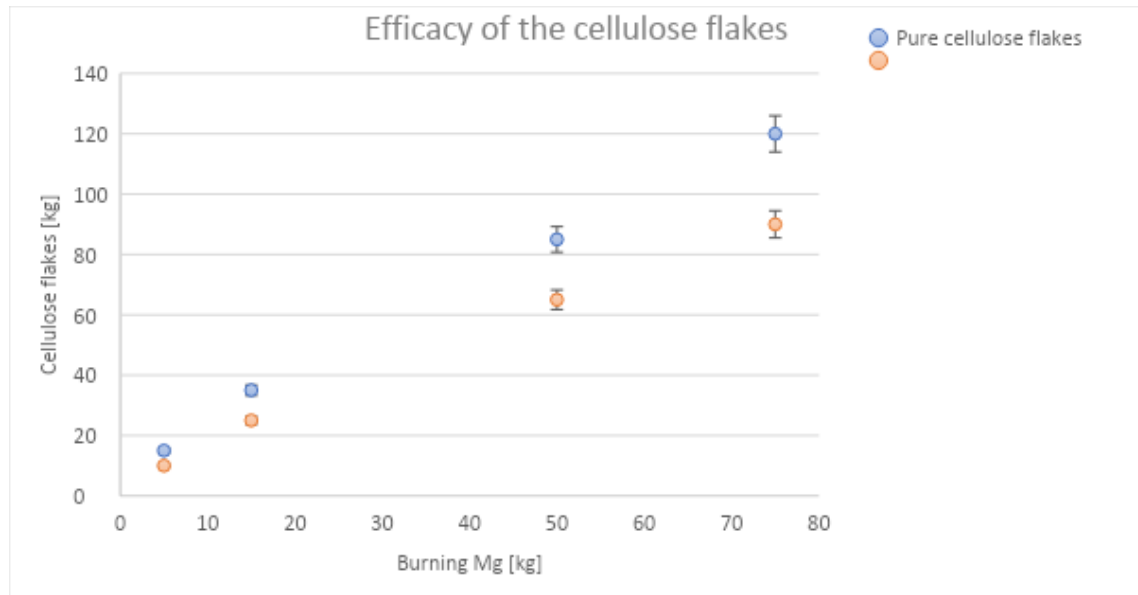
Figure 8. Smoke and fire in recycling companies in Japan. The increase in recent years can be at- tributed to lithium-ion batteries becoming damaged. Source: Statista (2021). attributed to lithium-ion batteries becoming damaged. Source: Statista (2021).